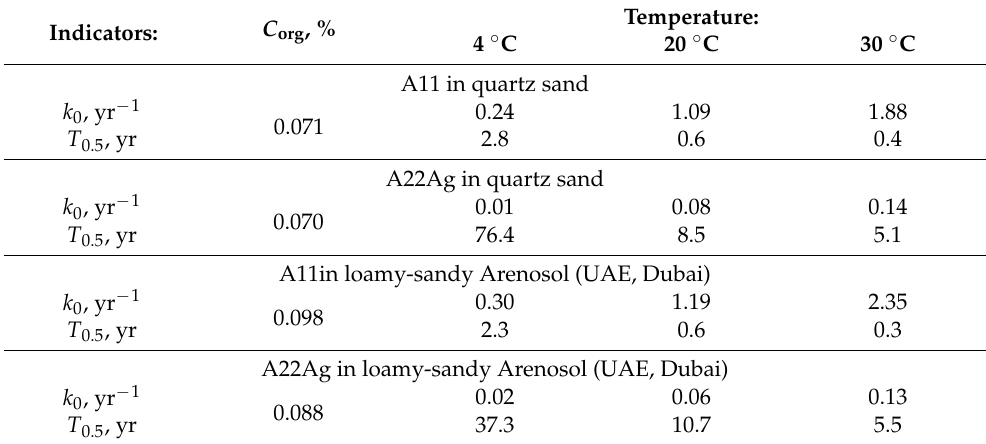
Table 7. Biodegradation constants and half-lives of hydrogels at optimal humidity for soil-gel